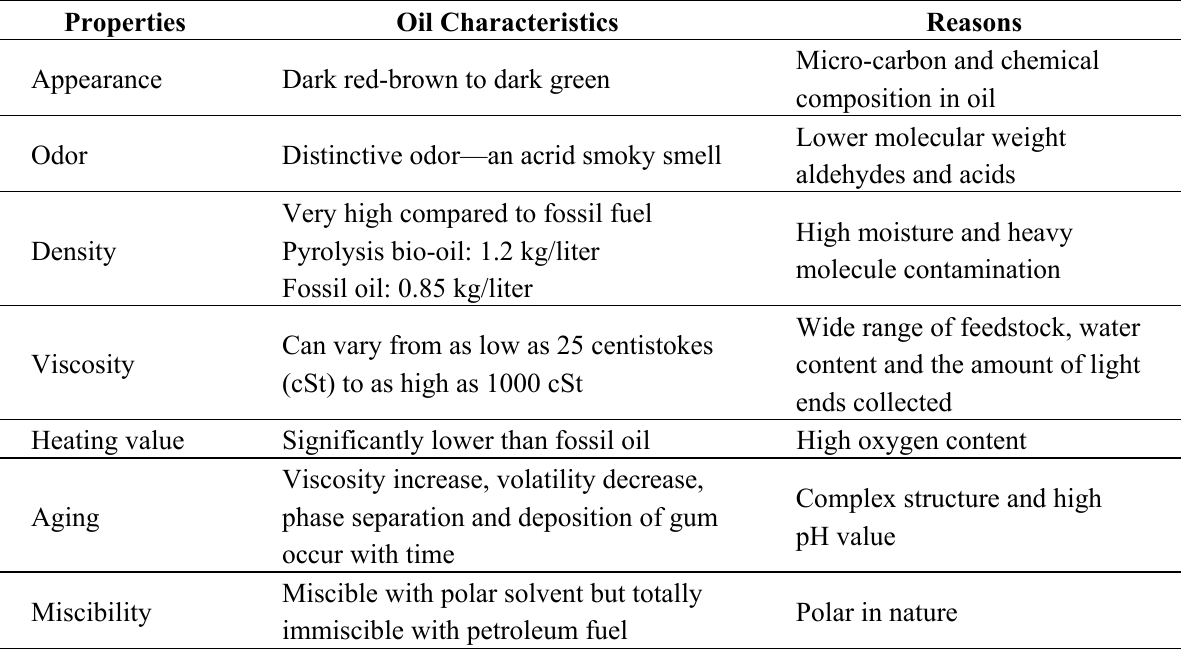
Table 7. Physical properties and characteristics of pyrolysis